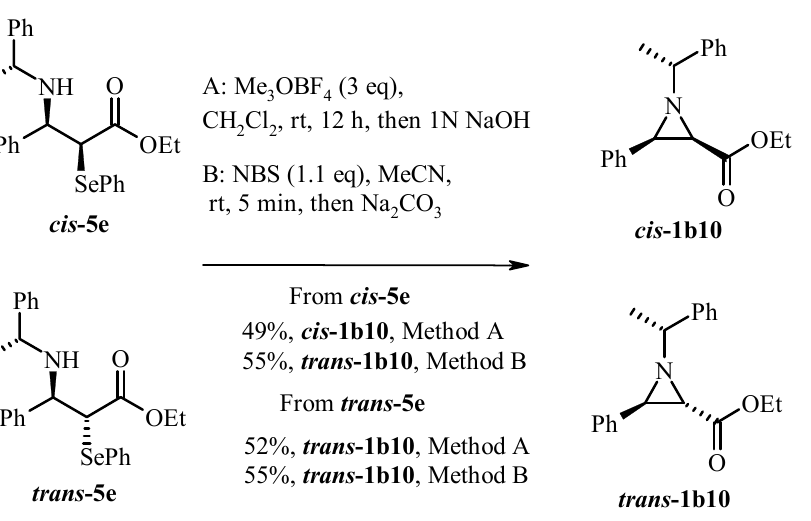
Scheme 13. Fluoroalkanosulphonyl fluoride-promoted cyclization of ester 4d .